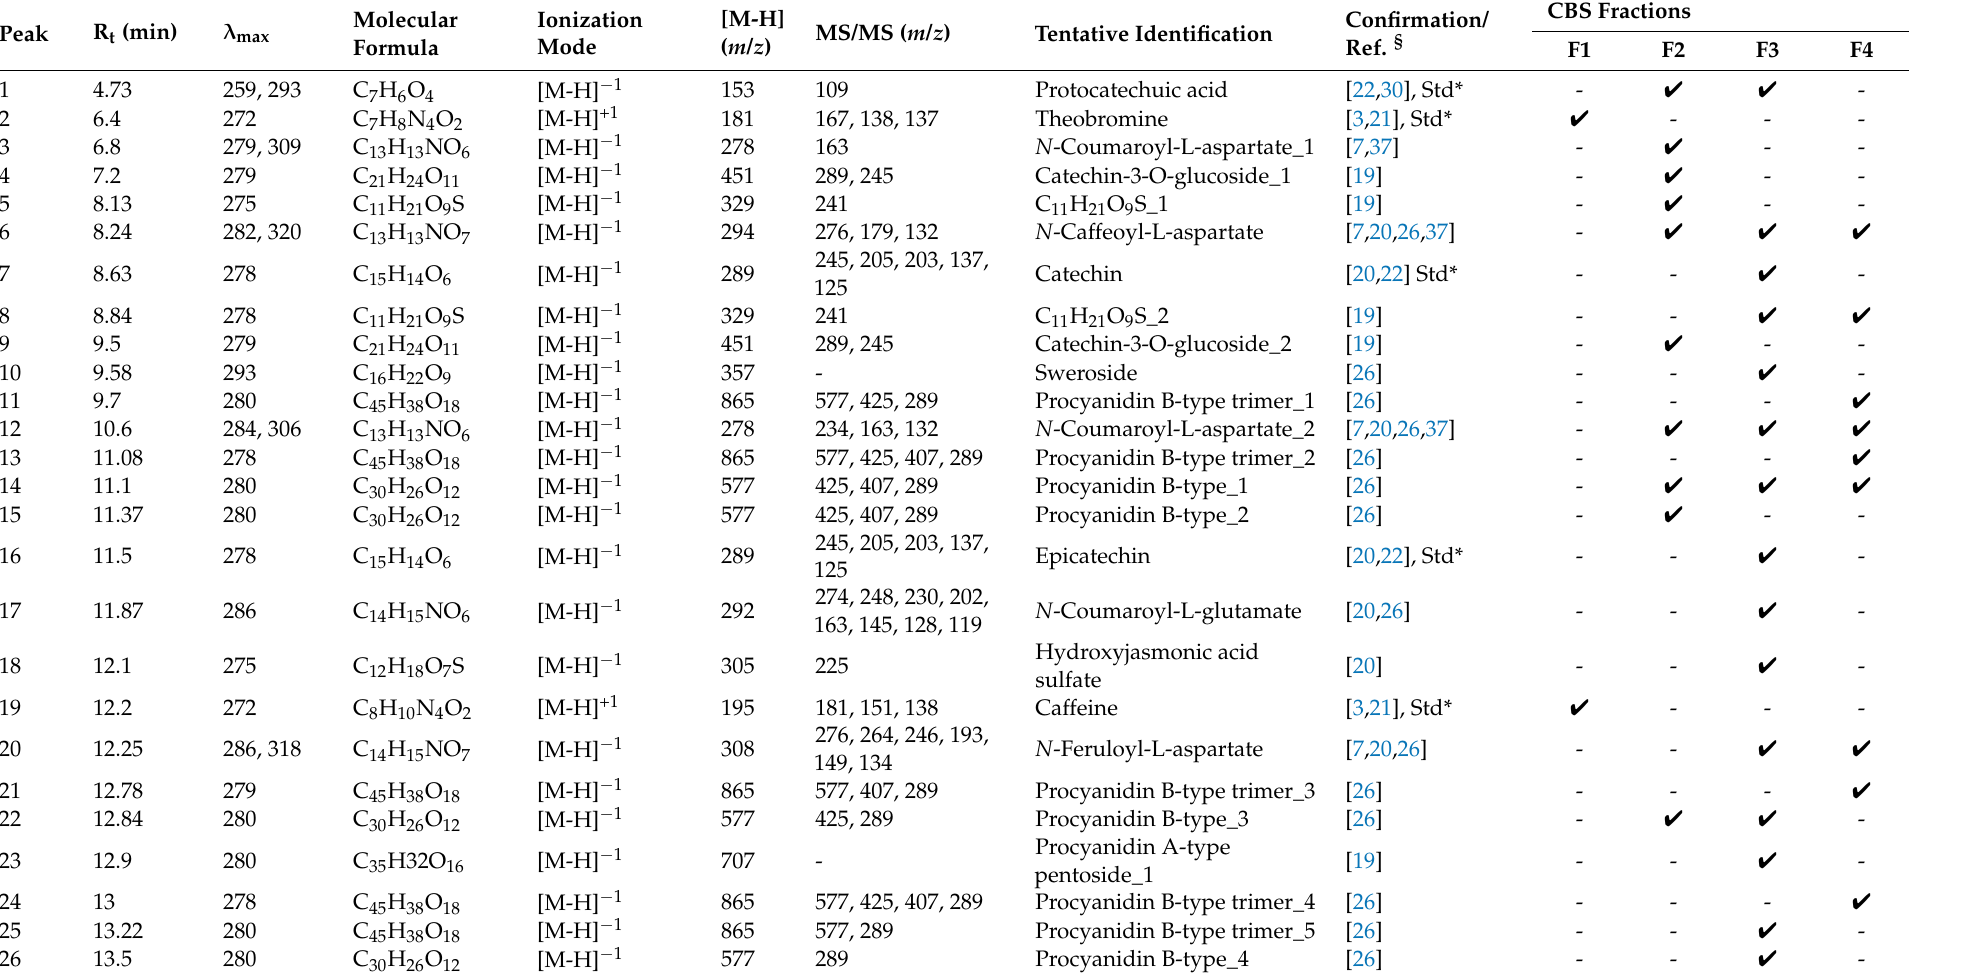
Table 1. Identification of chemical compounds in CBS fraction extracts yielded from roasted cocoa beans from different regions of